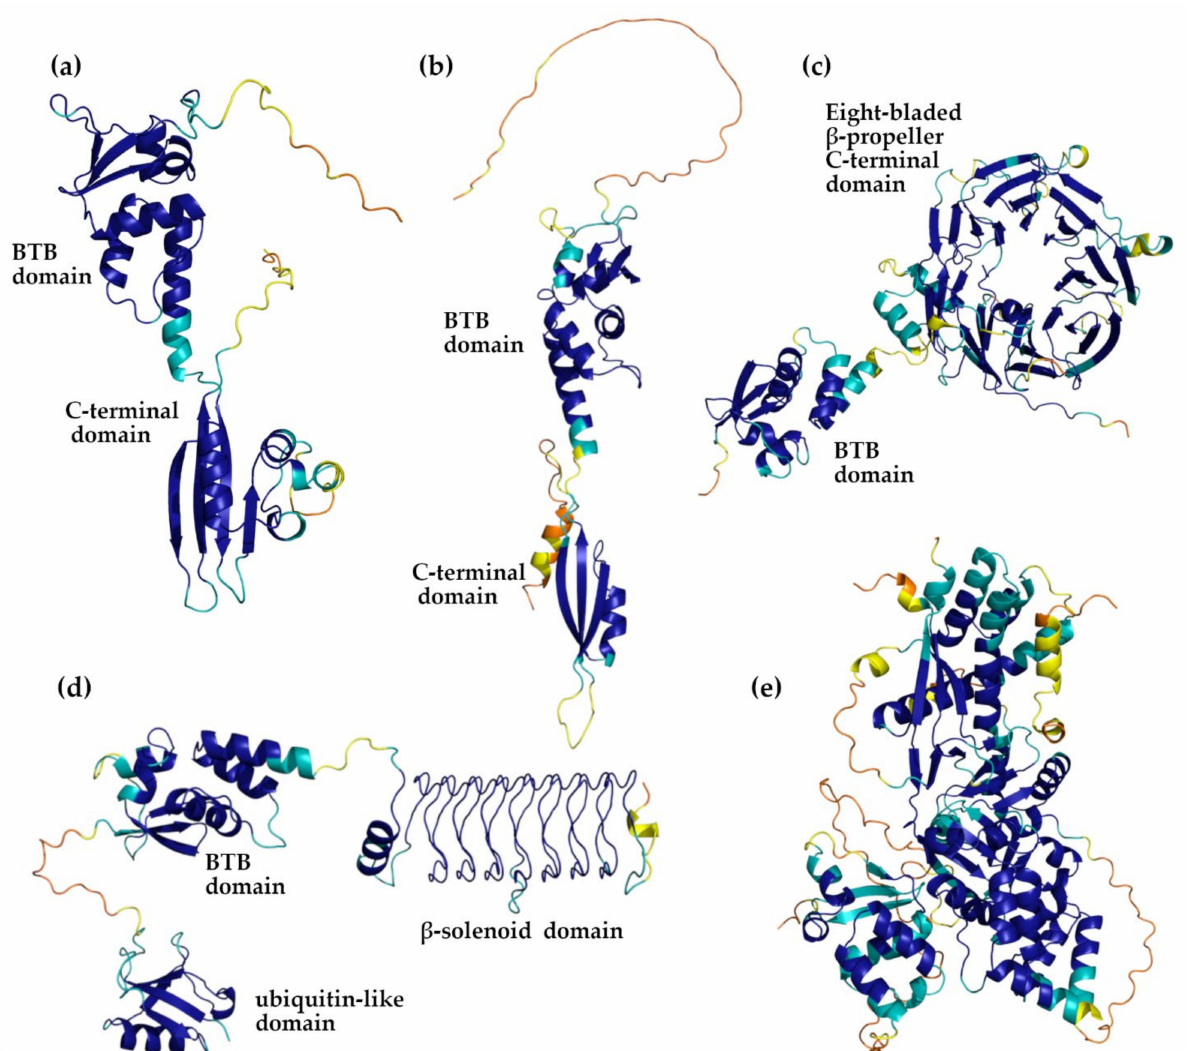
Figure 1. Representative AF-predicted models of the following KCTD proteins: KCTD1 ( a ), KCTD5 ( b ), KCTD3 ( c ), KCTD9 ( d ), and KCTD19 ( e ). The color code of the cartoons follows that used by AlphaFold to report the reliability of the models. Blue, cyan, orange, and yellow protein regions correspond to very high (LDDT > 90), high (90 > LDDT > 70), low (70 > LDDT > 50), and very low (LDDT < 50) model confidence,